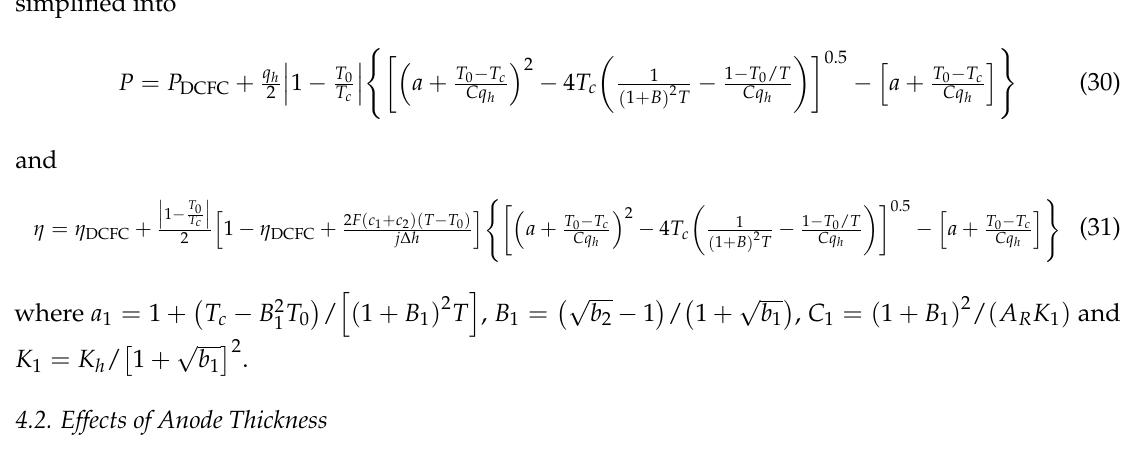
Figure 3. Effects of the internal irreversibility r